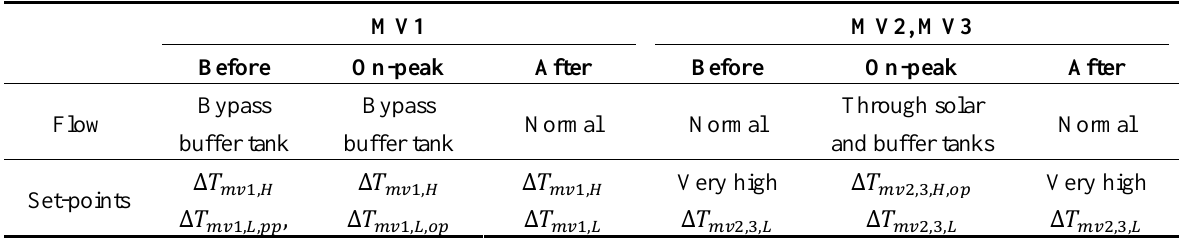
Table 2. Control modes applied to utilize solar heat during space heating.